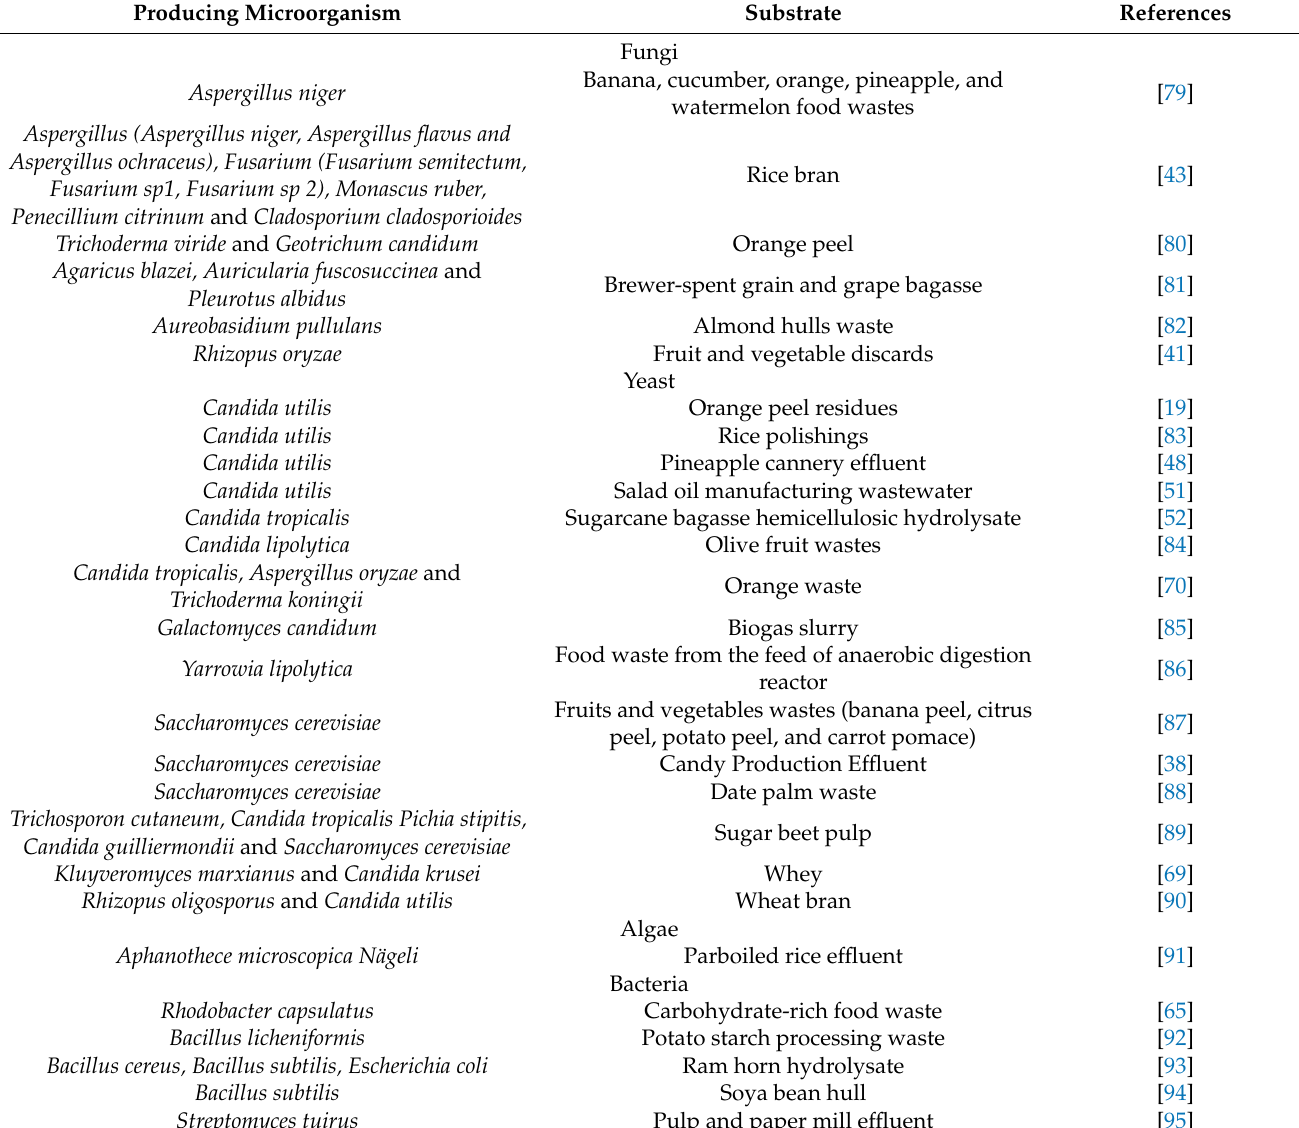
Table 2. SCP producing microorganisms used on different agro-industrial residues, wastes and by-products. Producing